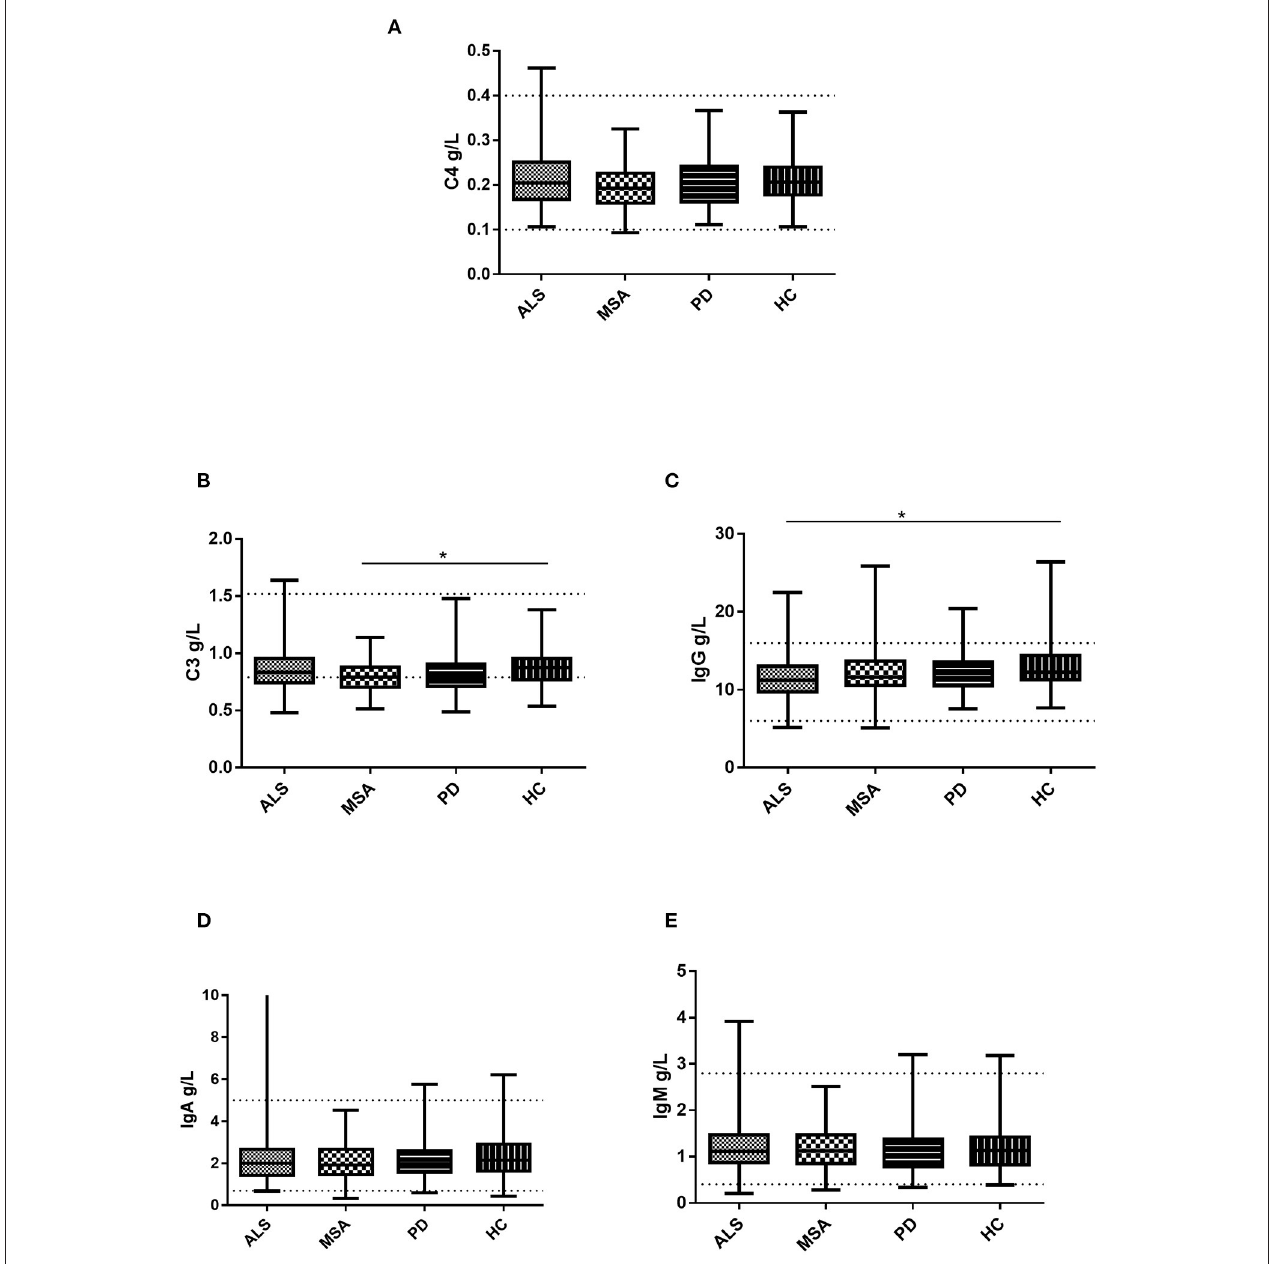
FIGURE 1 | Levels of the serum immunoglobulin and complement in patients with ALS, patients with MSA, patients with PD, and HCs. (A) Levels of serum C4 in patients with ALS, patients with MSA, patients with PD, and HCs. (B) Levels of serum C3 in patients with ALS, patients with MSA, patients with PD, and HCs. (C) Levels of serum IgG in patients with ALS, patients with MSA, patients with PD, and HCs. (D) Levels of serum IgA in patients with ALS, patients with MSA, patients with PD, and HCs. (E) Levels of serum IgM in patients with ALS, patients with MSA, patients with PD, and HCs. * p <